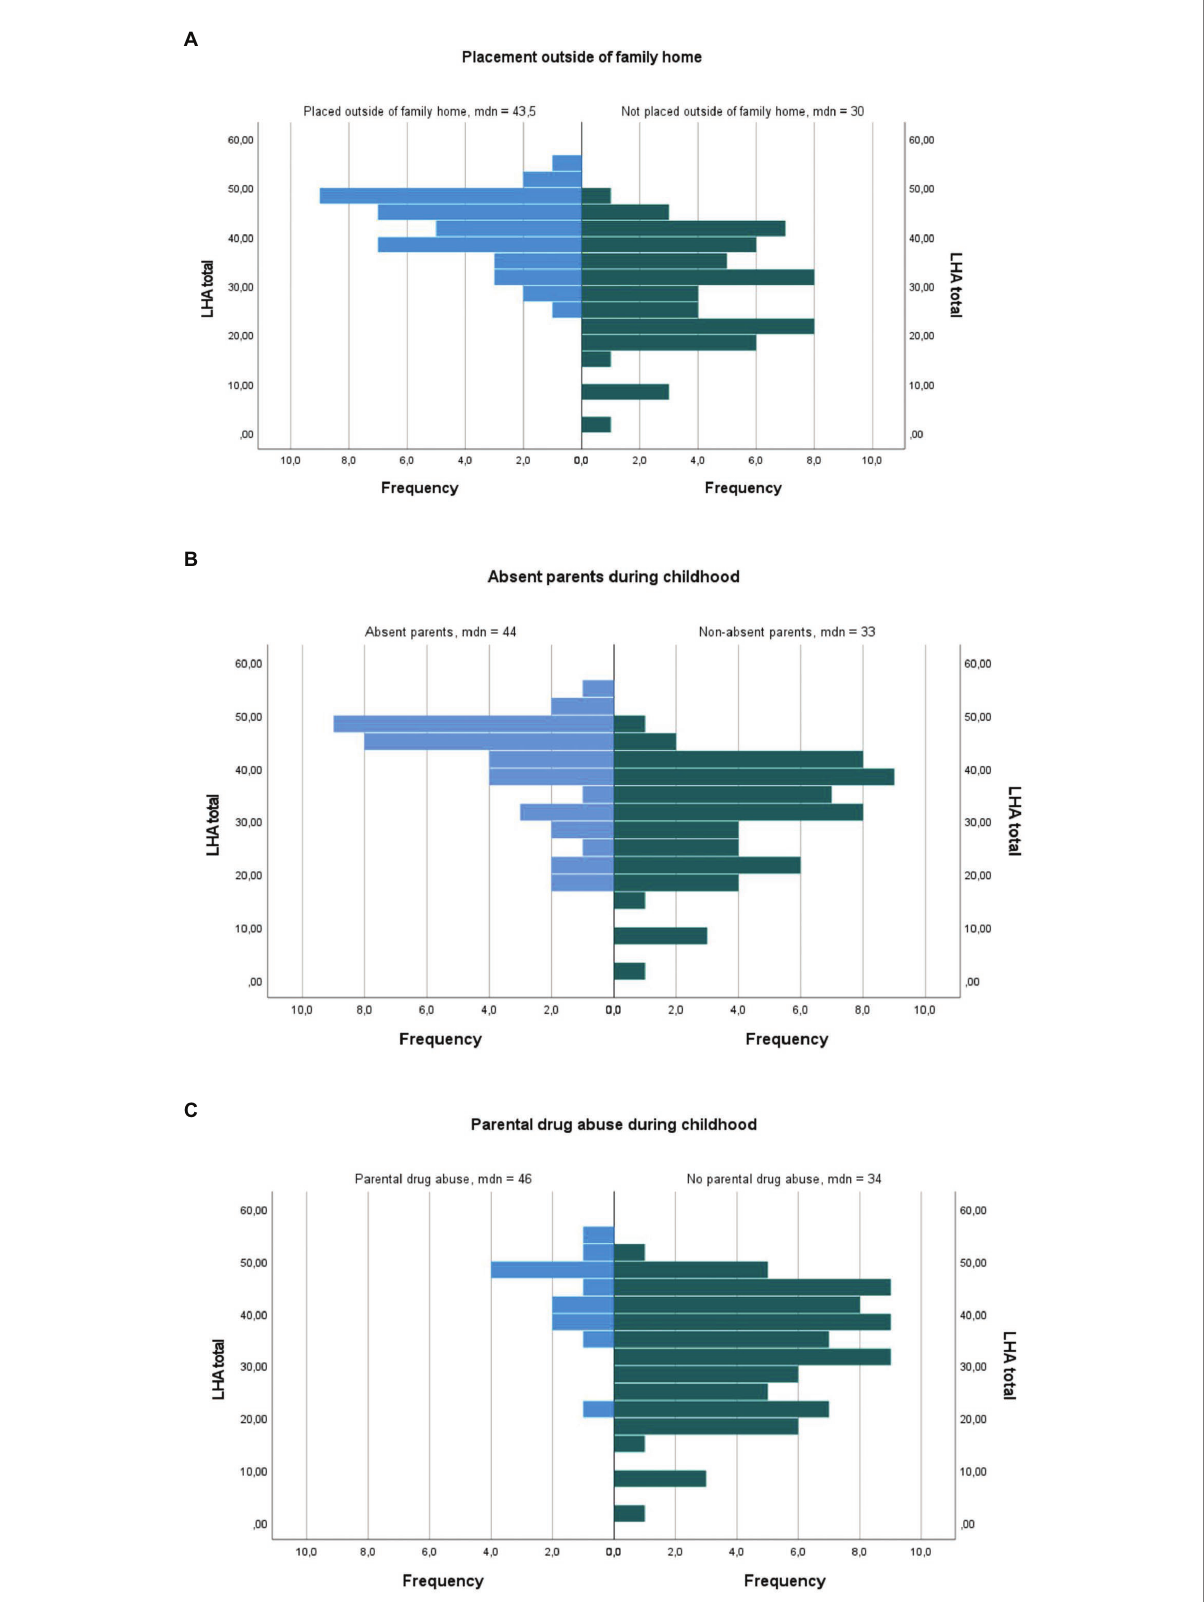
FIGURE 2 Population pyramids showing the distribution on level of AAB in three different ACE conditions. (A) Placement outside of family home. (B) Absent parents during childhood. (C) Parental drug abuse during